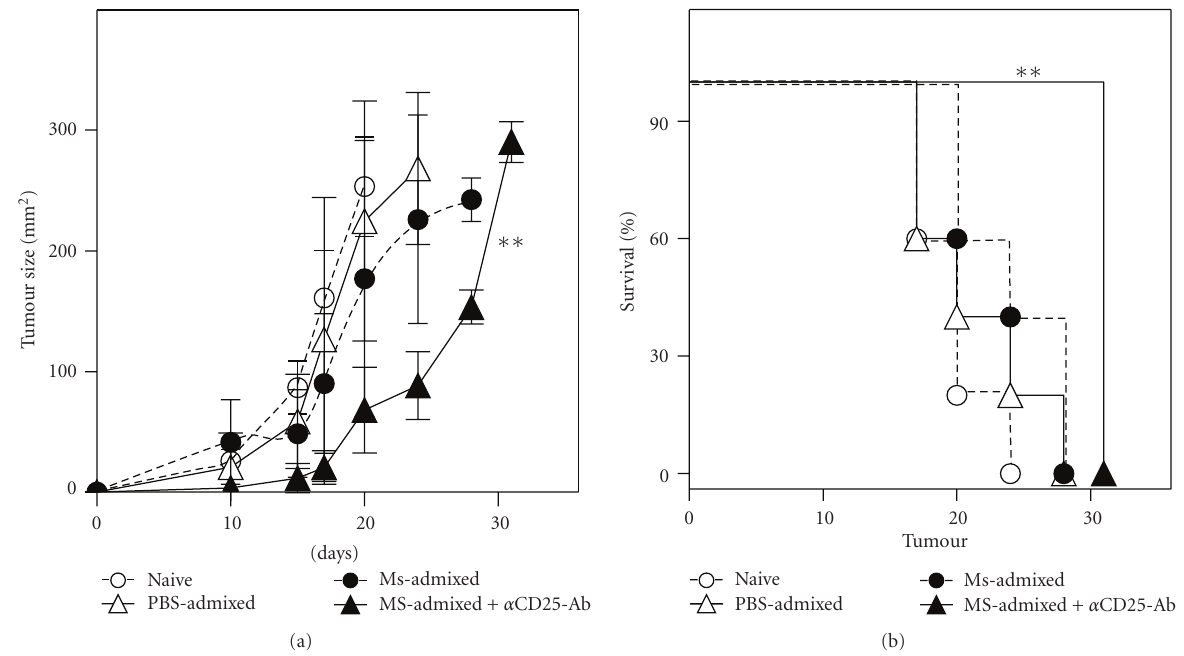
Figure 7: Therapeutic tumor protection by the dual melanoma antigen-archaeosome vaccine. Mice were injected with 10 5 B16 melanoma cells subcutaneously on day 0. Vaccination with 30 μ g of each peptide in PBS (PBS-admixed) or as mixture of Ms-Gp100 and Ms-TRP (Ms- admixed) was carried out on days 1 and 21 posttumor challenge. One group of mice received the anti-CD25 antibody injection (100 μ g), intraperitoneally on day 1 posttumor challenge. Mean tumor size ± SD ( n = 5/group) over time is indicated for all groups (a). Animals that received the Ms-admixed vaccine and anti-CD25 antibody showed significantly slower tumor progression over time based on one-way ANOVA Bonferronis Post-test compared to the na¨ıve group ( P < . 01). Tumor survival (b) is based on animals reaching a maximum tumor size of 300 mm 2 . Survival for the Ms-Admixed plus anti-CD25 antibody group was also significantly longer ( P < . 01) relative to the na¨ıve group ( n = 5 mice/group) based on Log rank test. The admixed group contained 2.2mg of lipid and 60 μ g of peptide (30 μ g of each